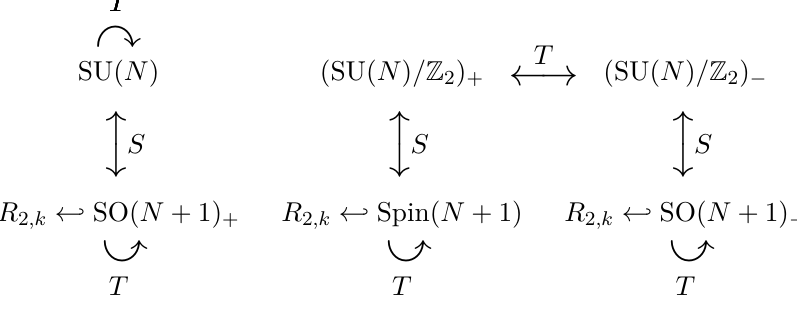
Figure 16. Duality orbits of the quiver (3.4) for N = 4 m + 2 ( N > 2 ).